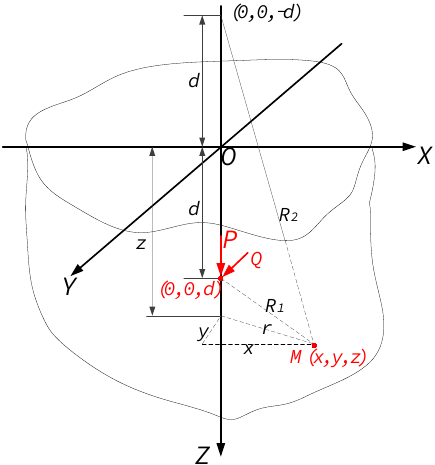
Figure 5. Mindlin model. Where M (x, y, z) is any point in the infinite half space; P is a vertical concentrated load; Q is a horizontal concentrated load; d is the burial depth of concentrated load; (cid:113) (cid:113) (cid:112) R 1 = r 2 + ( z − d ) 2 ; R 2 = r 2 + ( z + d ) 2 ; r = x 2 + y 2